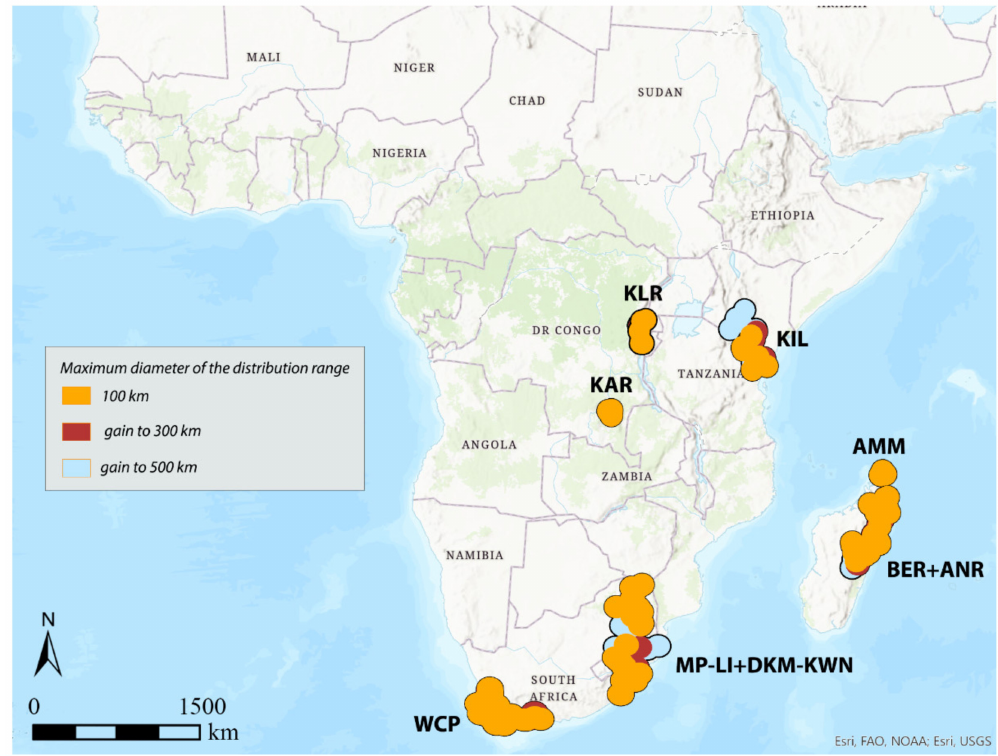
Figure 8. Areas of endemism detected by DBSCAN using the distance between centroids to 150 km and species with distribution range up to 100, 300, and 500